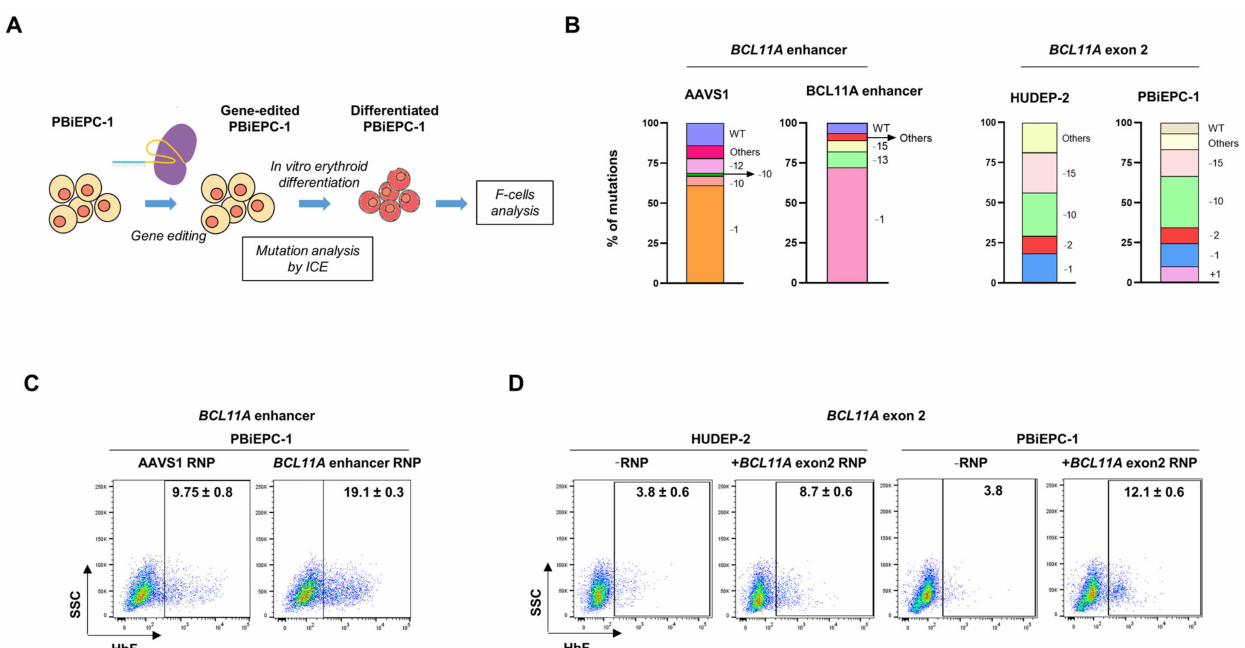
Figure 5. CRISPR-Cas9 mediated gene editing of BCL11A enhancer and exon 2 in PBiEPC-1. ( A ) Schematic representation of the CRISPR/Cas9 experiment in PBiEPC-1. ( B ) Inference of CRISPR Edits (ICE) analysis results of gene editing at the BCL11A enhancer and exon 2. The percentages of different types of mutations are shown. “+” indicates insertions, and “–“ indicates deletions of nucleotides. “WT” indicates wild type sequence, and “others” indicates rare insertions and deletions. ( C ) Flow cytometry analysis of F-cells in the cells edited at BCL11A enhancer and AAVS1 (control genomic region). Numbers indicate mean ± standard deviation (SD) from two independent experiments. ( D ) Flow cytometry analysis of F-cells after editing at BCL11A exon 2 in PBiEPC-1 and HUDEP-2. Numbers indicate mean ± standard deviation (SD) from two independent experiments. RNP: ribonucleoprotein complex containing Cas9 protein and